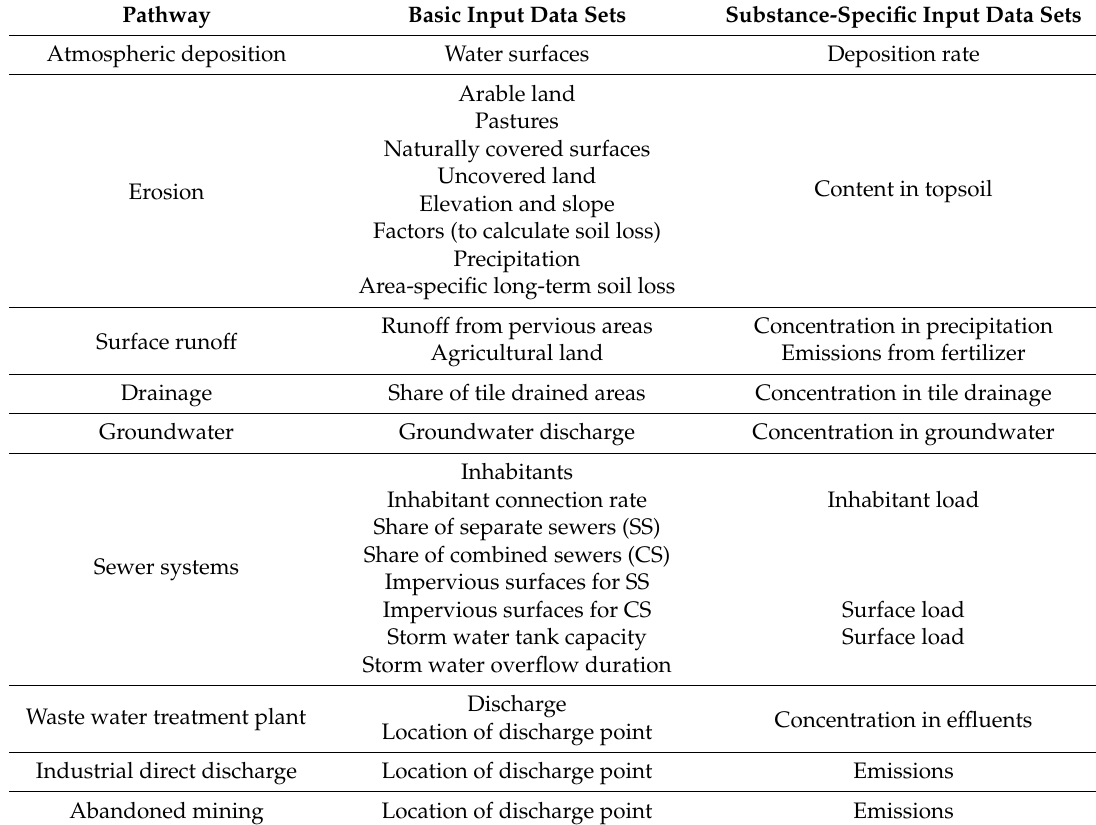
Table 1. Example of pathways with their corresponding most important input data